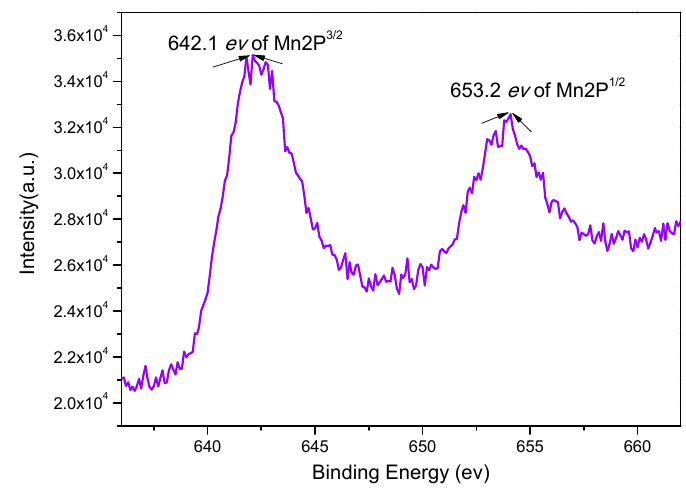
Figure 6. X-ray photoelectron spectroscopy (XPS) spectra of catalyst 3.